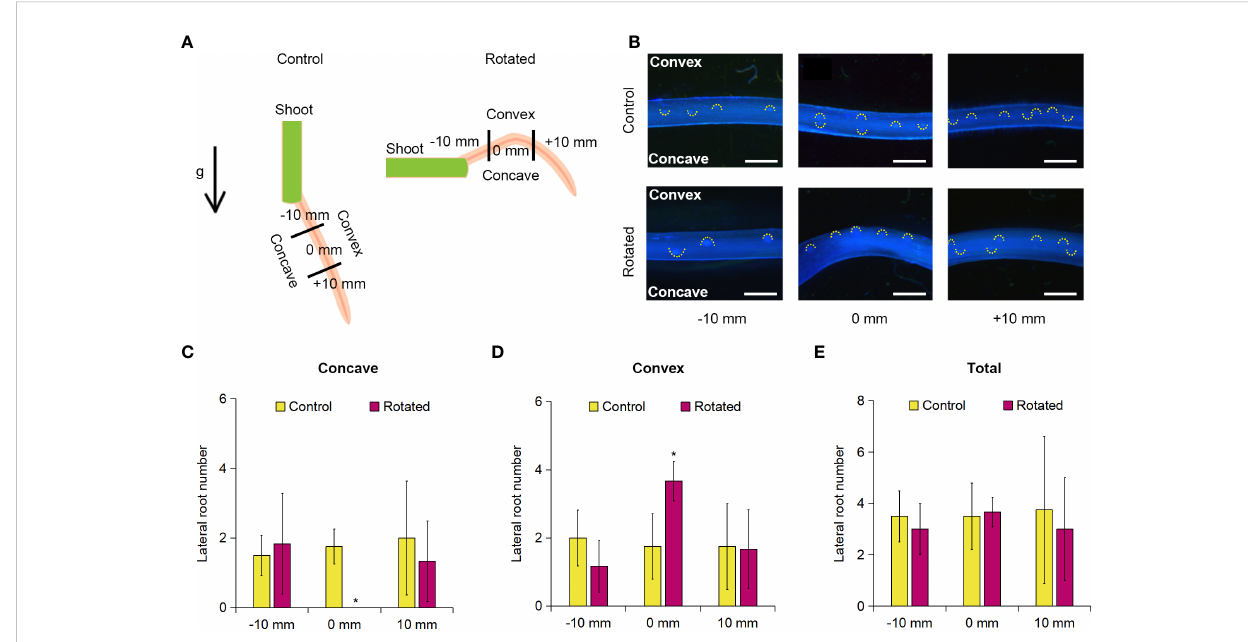
FIGURE 3 Lateral root formation on the concave and convex sides of the gravity-stimulated nodal roots of Z. nicaraguensis . (A) Diagram of gravistimulation experiment. The arrow indicates the direction of gravity (g) during the control and rotated treatments. (B) Pictures of lateral root primordia in the control and rotated nodal roots in the bent region (0 mm ± 2 mm) and at 10 mm (± 2 mm) from the bending position (at 0 mm). The basal and apical directions from the upright position are indicated with minus ( − ) and plus (+) signs, respectively. LR primordia were visualized using DAPI staining. Scale bars = 1 mm. Numbers of lateral root primordia at − 10, 0, and +10 mm on the concave side (C) and convex side (D) and the total number of lateral root primordia in the nodal roots (E) . Signi fi cant differences between the control and rotated nodal roots at p < 0.05 (two-sample t- test) are denoted with asterisks. Values are mean ± SD ( n = 3 to